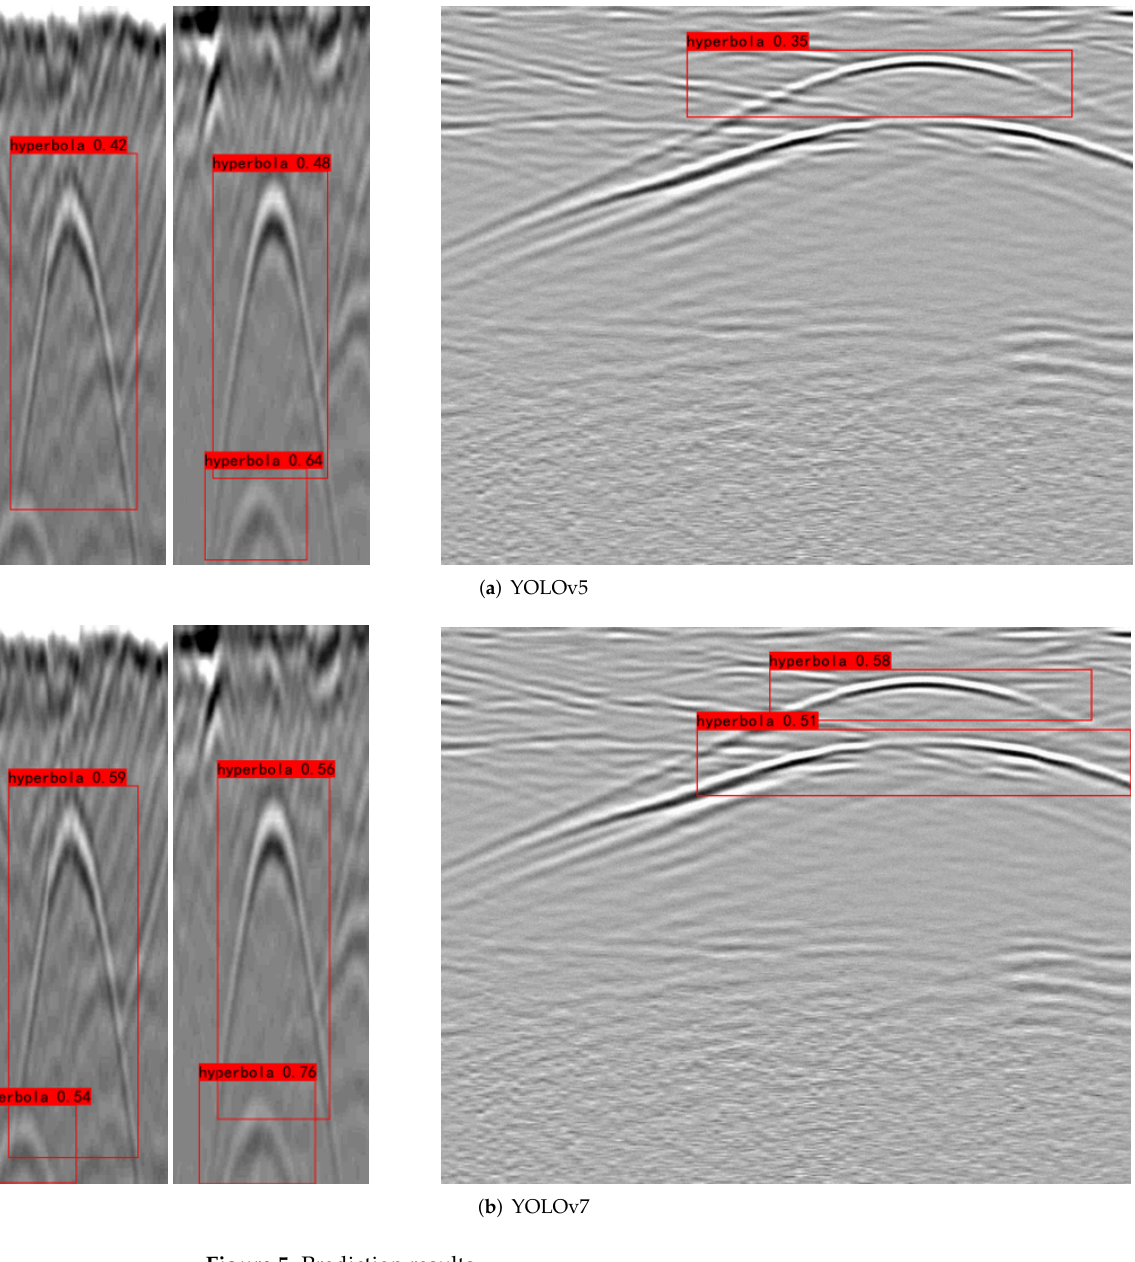
Figure 5. Prediction